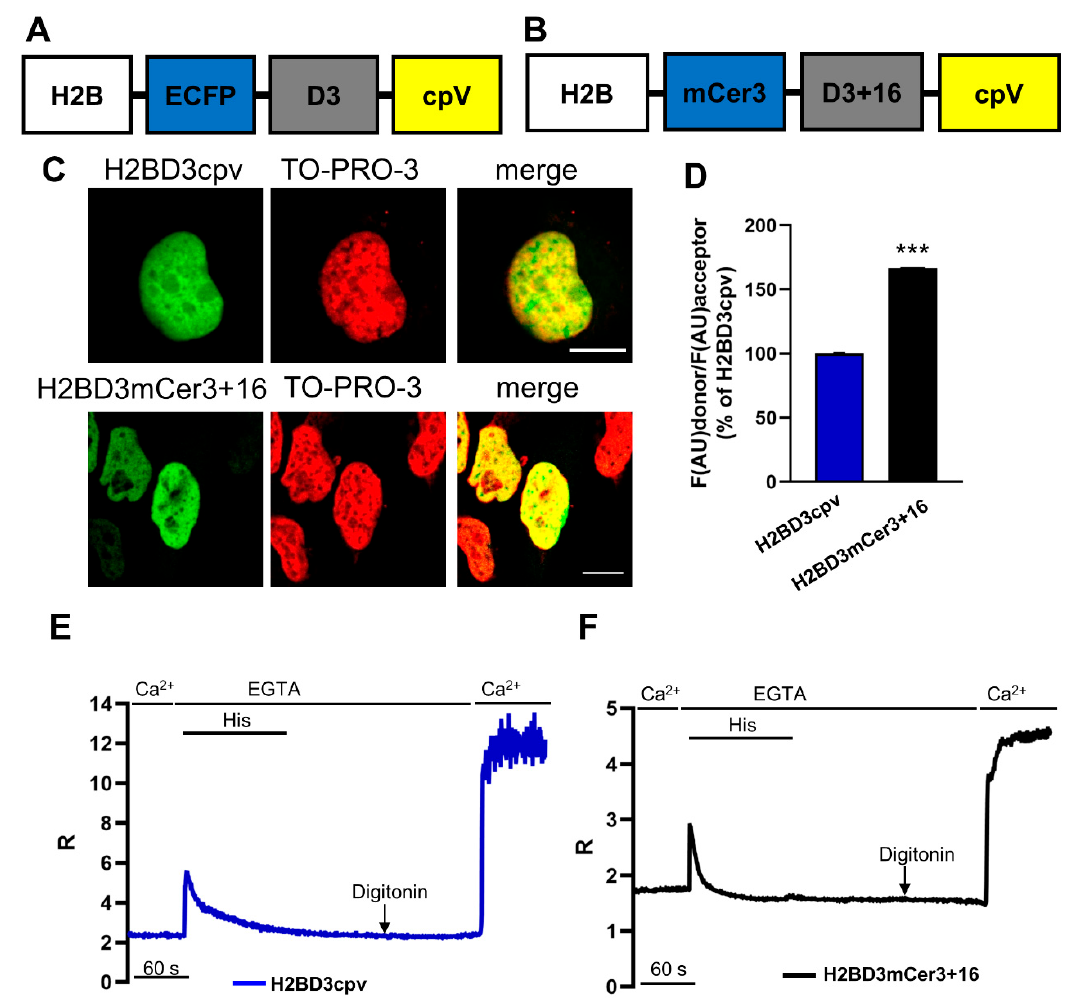
Figure 1. Generation and characterization of a new nuclear Ca 2+ probe based on D3cpv. ( A , B ) Schematic representation of the nucleus-targeted D3cpv-based constructs H2BD3cpv ( A ) and H2BD3mCerulean3+16 ( B ). ( C ) H2BD3cpv (top) and H2BD3mCerulean3+16 (bottom) correctly localize in the nucleus. Confocal images of HeLa cells expressing H2BD3cpv or H2BD3mCerulean3+16 probe (green) and labelled with TO-PRO-3 dye (red). The yellow color represents the superimpo- sition of the Cameleon and TO-PRO-3 signals. Scale bar, 10 µm. ( D ) The bar chart represents the mean ± SEM of ECFP and mCerulean3 fluorescence, normalized to cpV fluorescence, in HeLa cells expressing nuclear Cameleon probes. n ≥ 69 cells for each condition. Data are shown as % of H2BD3cpv. ( E , F ) Representative kinetics of nuclear R values in a single HeLa cell expressing H2BD3cpv ( E , blue) or H2BD3mCerulean3+16 ( F , black) stimulated with histamine (His, 100 µM) in a Ca 2+ - free extracellular medium, then permeabilized with digitonin (100 µM) in an intracellular medium containing EGTA (600 µM), and finally perfused with an intracellular medium containing CaCl 2 (3 mM). Data are plotted as R, as defined in Materials and Methods. *** p < 0.001.